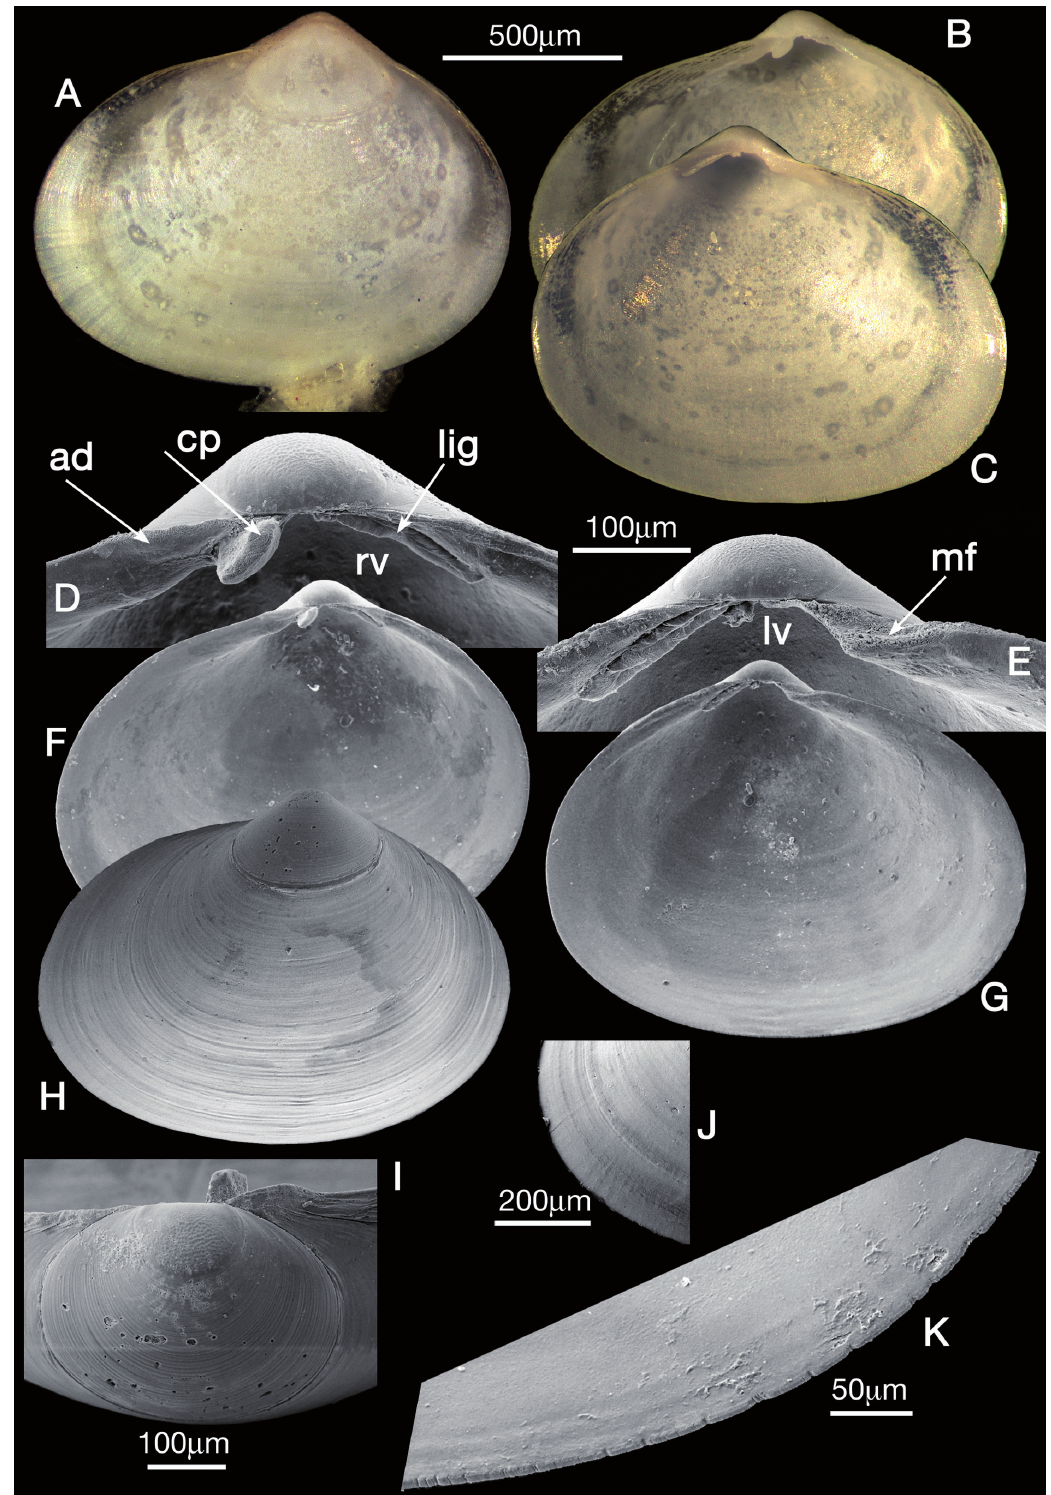
Fig. 3. Kelliola symmetros (Jeffreys, 1876) from Biscay. A-C . Photo micrographs a external of left valve, internals of both valves. D-E . SEM of hinges of right and left valves. F-H . SEM of internal of both valves and external of left valve. I . SEM of prodissoconch. J . SEM of anterior area showing weak radial sculpture. K . SEM of margin showing transverse